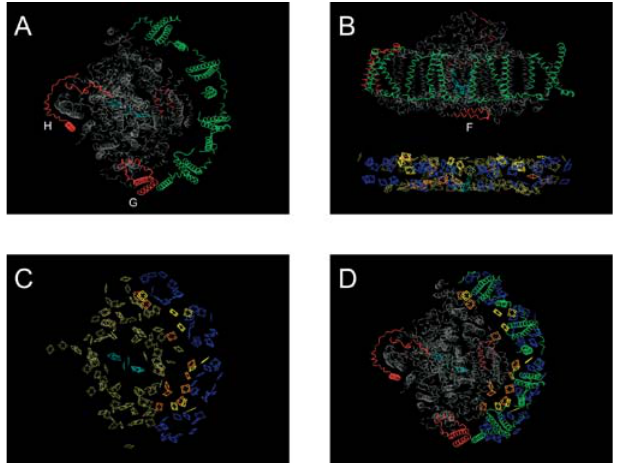
Figure 5. Crystal Structure of PS-I as Determined by Ben-Shem et al. [7,53], Visualized in VMD [52], and Rendered with POV-Ray 3.6 The color scheme is adapted from Ben-Shem et al. [7,53] and is interpreted as follows. Portions shown in gray are common subunits found in both PS-I reaction centers in cyanobacteria and higher plants, while the red subunits are unique to higher plants. The two LHCI heterodimers are shown in green. The two different orientations of selected PS-I complex are shown top-down (A) and in a side view (B). In (C) and (D) the chlorophyll molecules are colored by a putative function: the P700 core antennae are tan, the special pair (P700) and voyeur chlorophyll molecules are cyan, the linker chlorophyll between the LHCI heterodimers is in yellow, the antennae chlorophyll molecules com- plexed within an LHCI subunit are in blue, and the ‘‘ gap ’’ chlorophyll molecules are shown in orange. (A), (C), and (D) are views looking down on the stromal hump highlighting protein, chlorophyll, and composite, respectively. (B) faces the LHC belt from inside the plane of the thylakoid membrane; only protein is shown in the upper portion and only chlorophyll